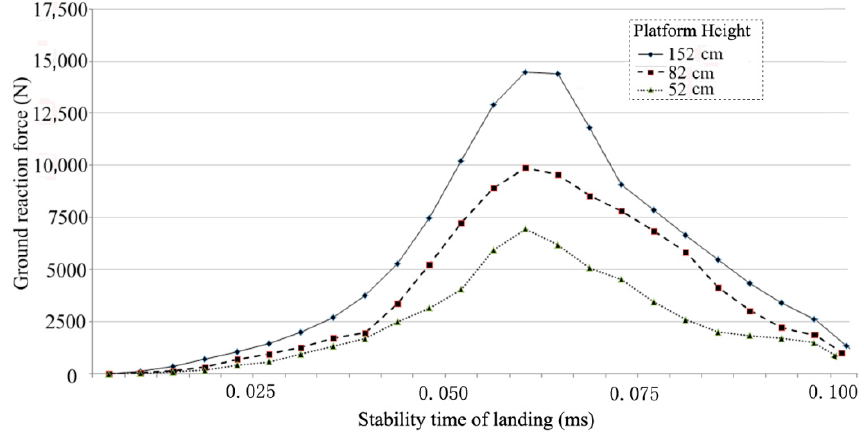
Figure 2. The dynamic stability time of subjects from the different height platforms (52, 82, and 152 cm).